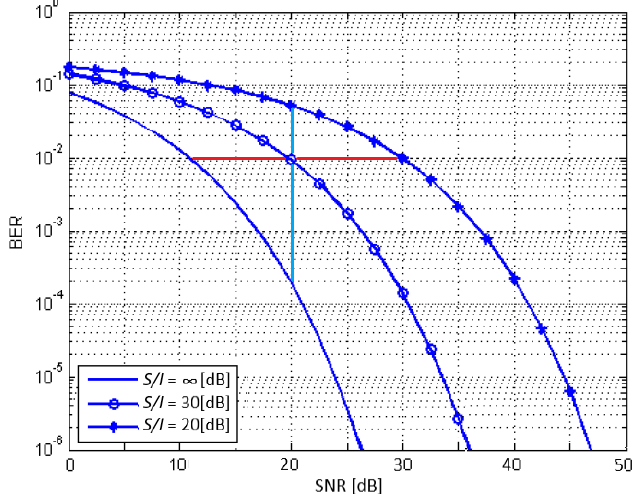
Figure 5. Graphical illustration of AWGN to non-AWGN trade-off for 16 QAM modulation. Specifically, moving to the right along the red horizontal line of constant BER = 10 −2 from the middle curve for S/I = 30 dB, to the line crossing with the utmost right curve for S/I = 20 dB (i.e., increasing the interference for 10 dB), is tracked by almost equal increase in the SNR value.